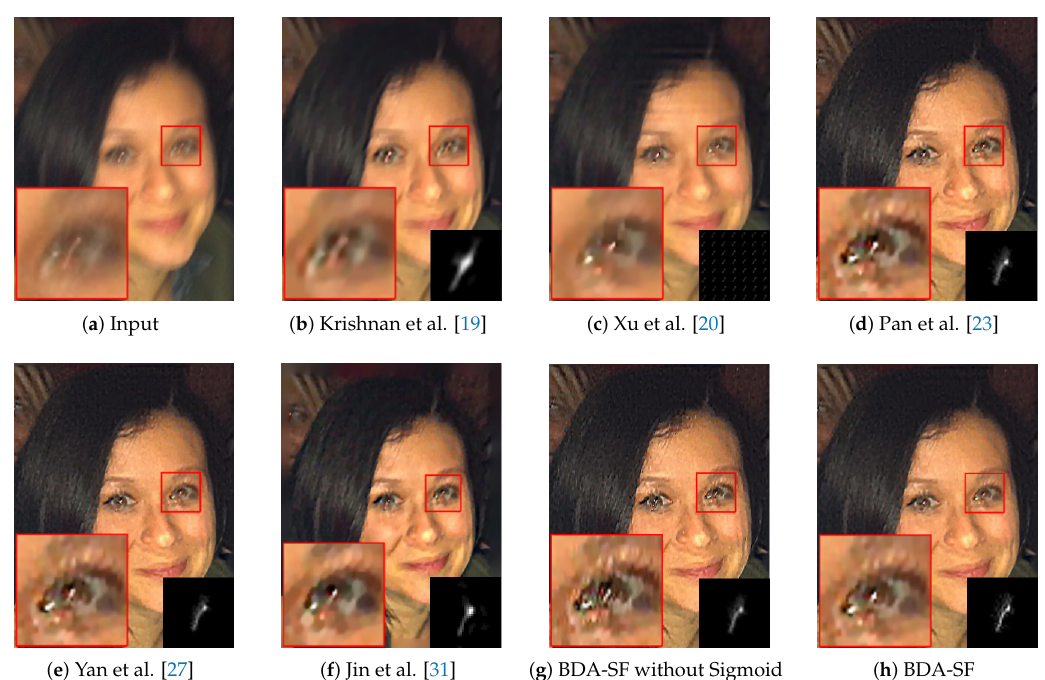
Figure 16. Visual comparison on a face image. BDA-SF achieves comparable visual results with method [23,27,31]. (Best viewed on high-resolution display with zoom-in).